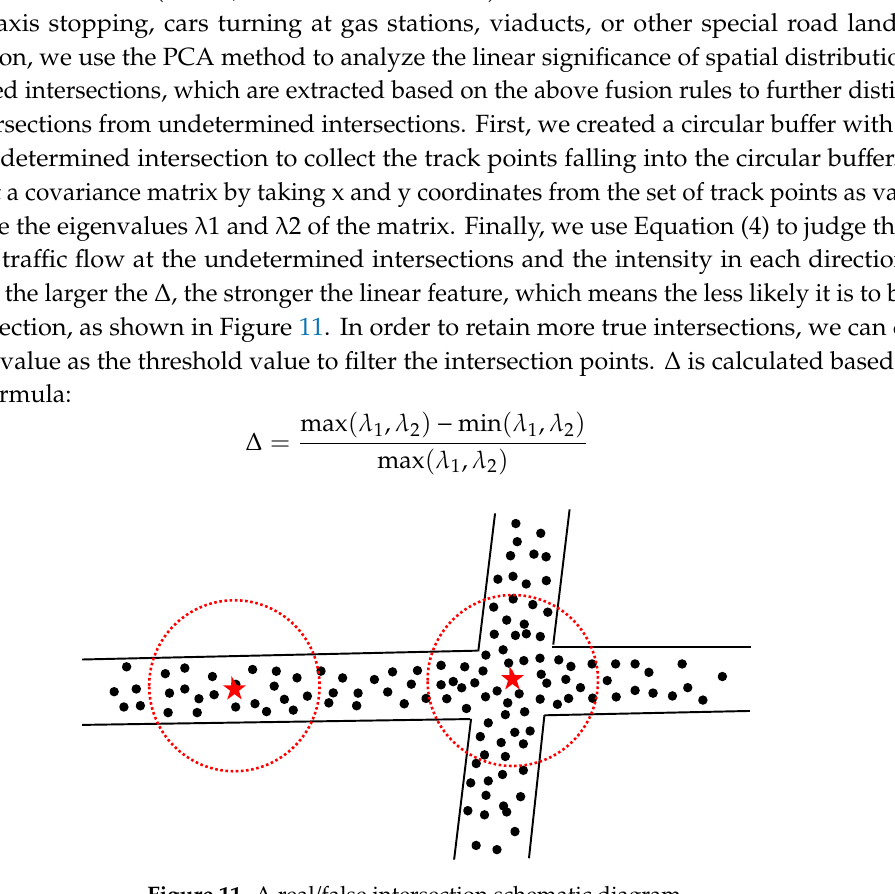
Figure 11. A real / false intersection schematic